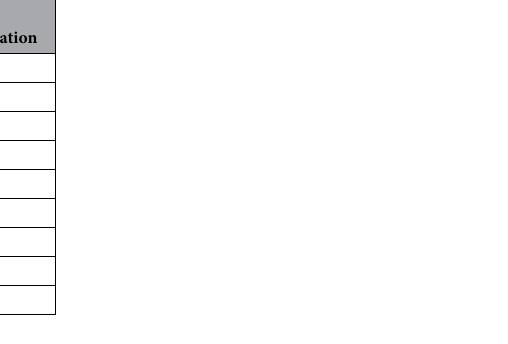
Table 2. Summary of the miRNA of the